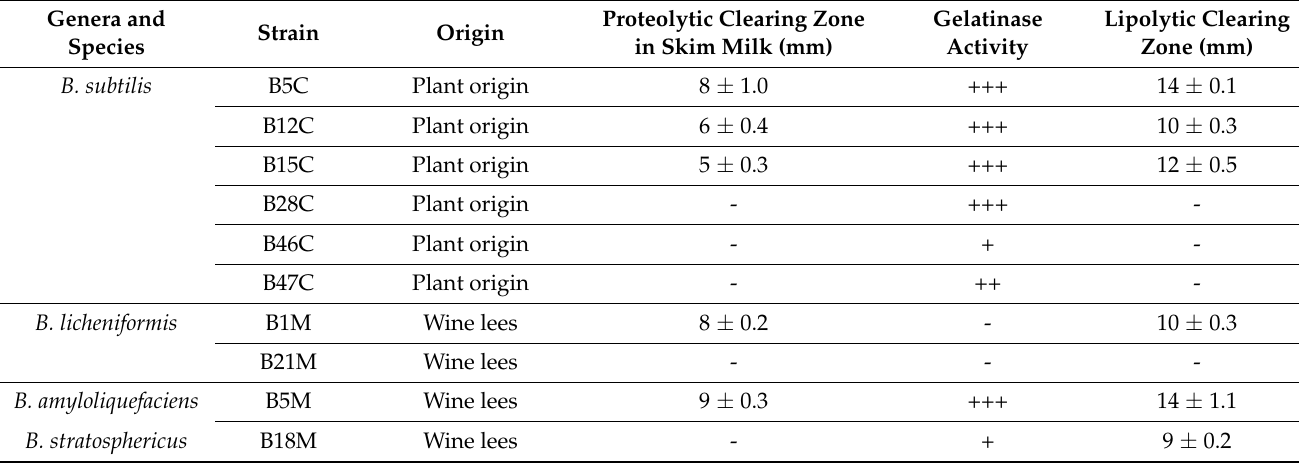
Table 1. Results of enzymatic properties of the different tested strains on different substrates. The results are the mean of three replicates ( n =